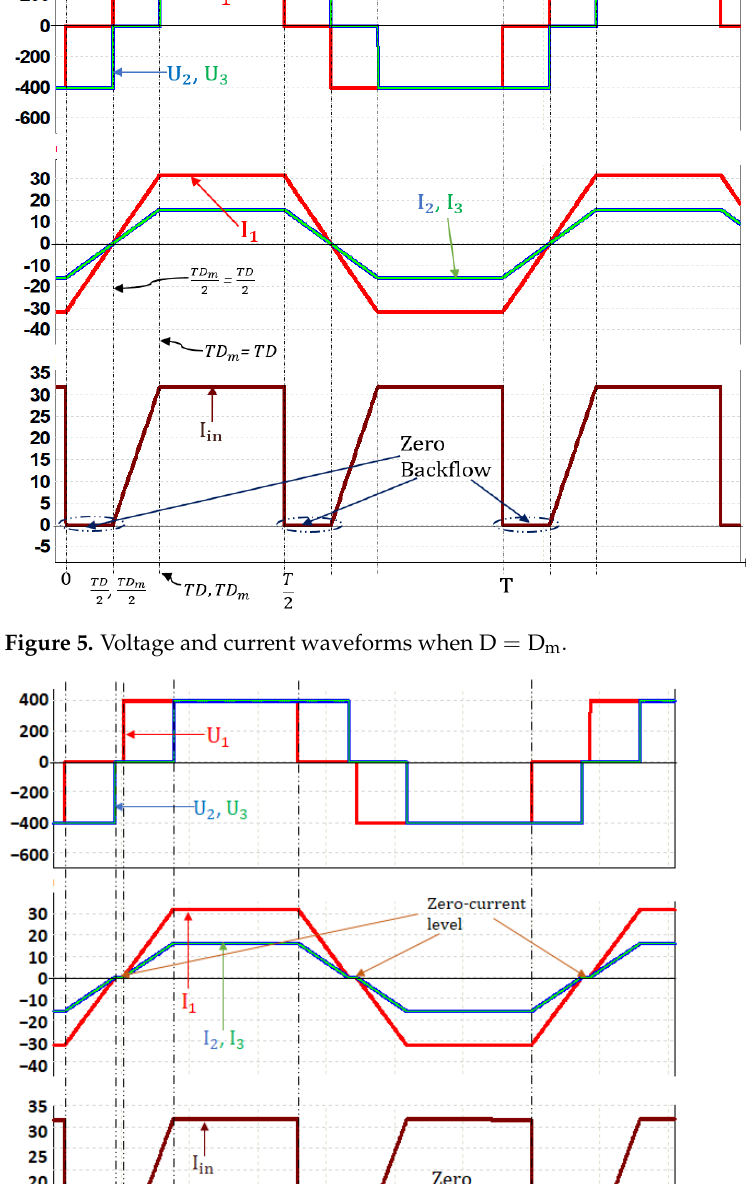
Figure 6. Voltage and current waveforms when D > D m .